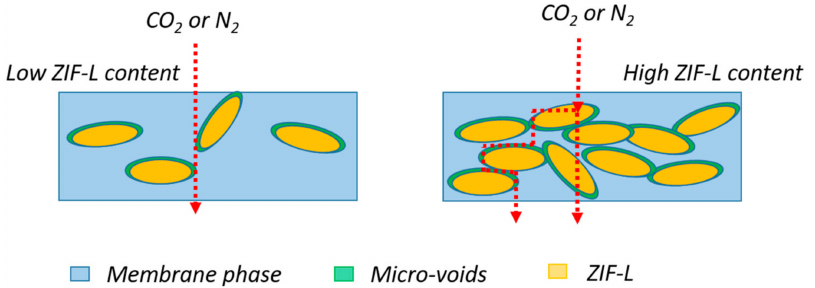
Figure 11. Possible gas transport mechanism in PTMSP/ZIF-L membranes.